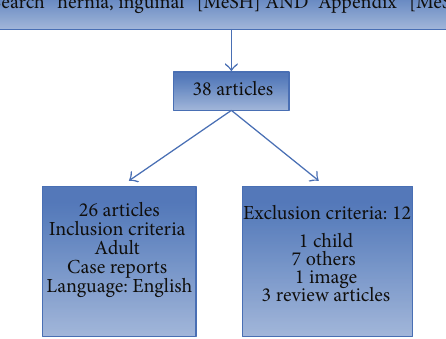
Figure 1: Flowchart from PubMed using the MeSH terms “hernia, inguinal” AND “Appendix.”